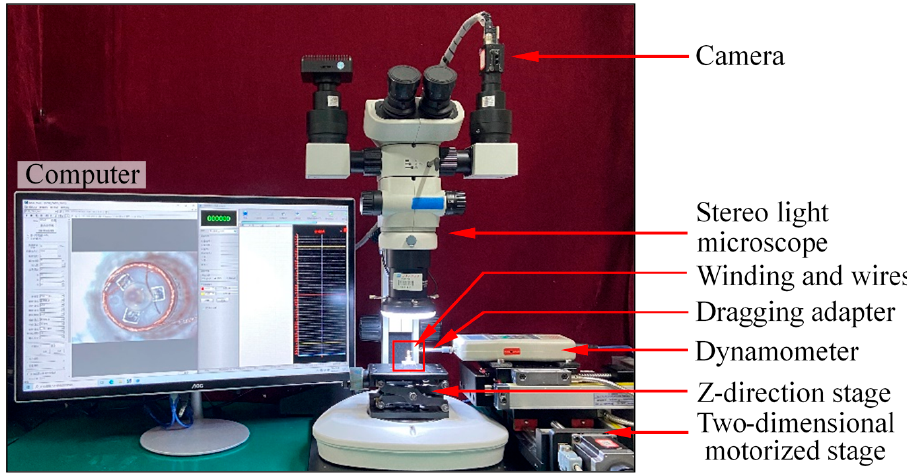
Figure 12. Setup of experimental system.